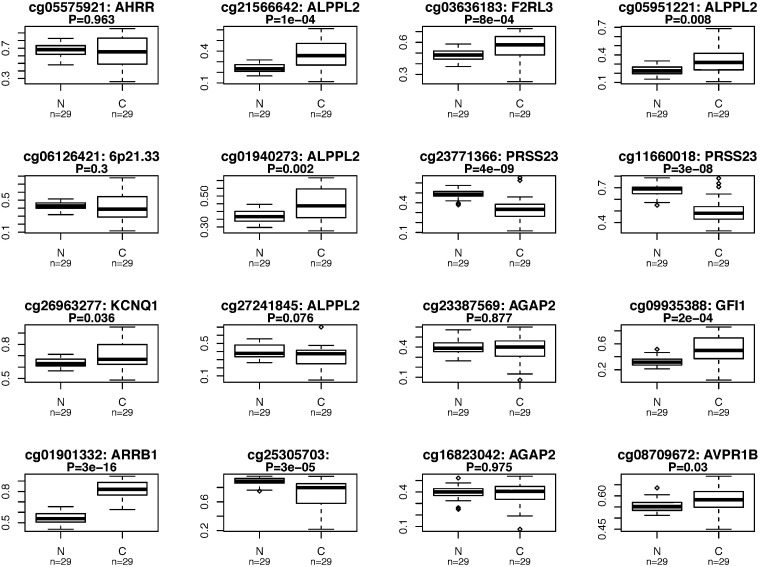
Differential DNA methylation in lung cancer tissue: a comparison of methylation at each of the 16 CpG sites identified in our meta-analysis was made between lung cancer tissue and adjacent healthy lung tissue for patients with: a) lung adenocarcinoma; and b) squamous cell lung cancer. Publicly available Data from The Cancer Genome Atlas were used for this analysis.